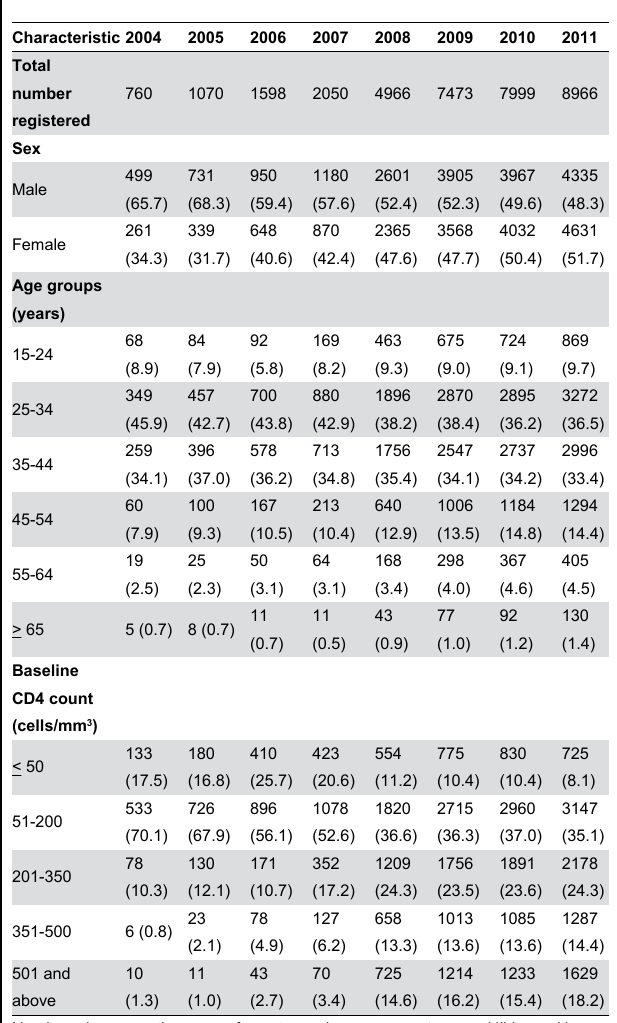
Table 1. Trends in characteristics of newly diagnosed HIV- infected individuals registered for HIV care at antiretroviral therapy centres in Karnataka, India,